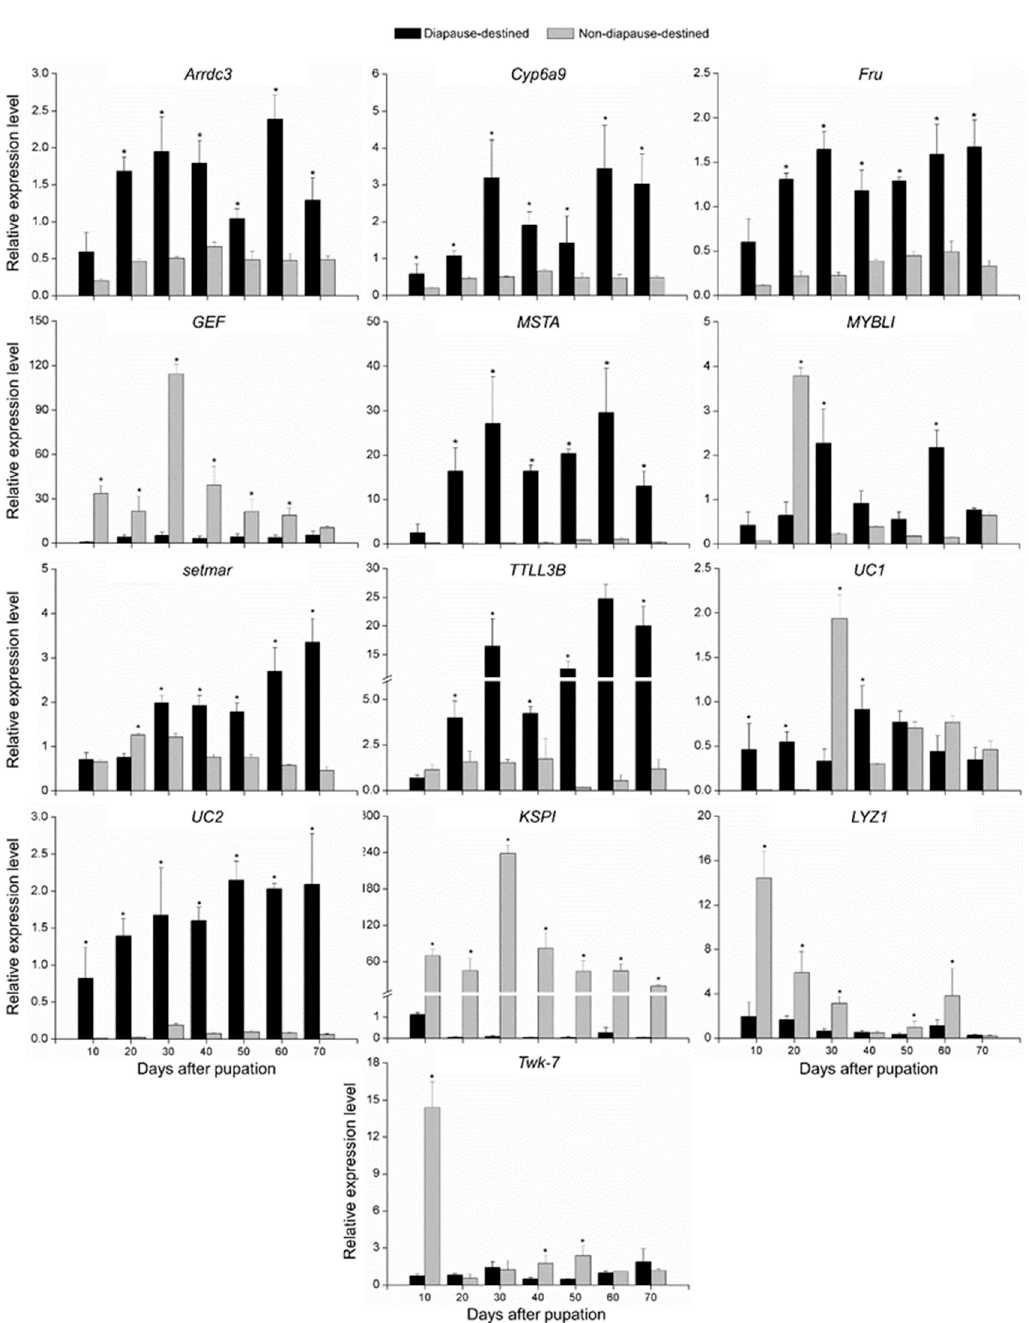
Figure 3. Relative gene expression levels between diapause-destined and non-diapause-destined B. minax pupae measured by qRT-PCR. Asterisks indicate significant differences ( p < 0.05).